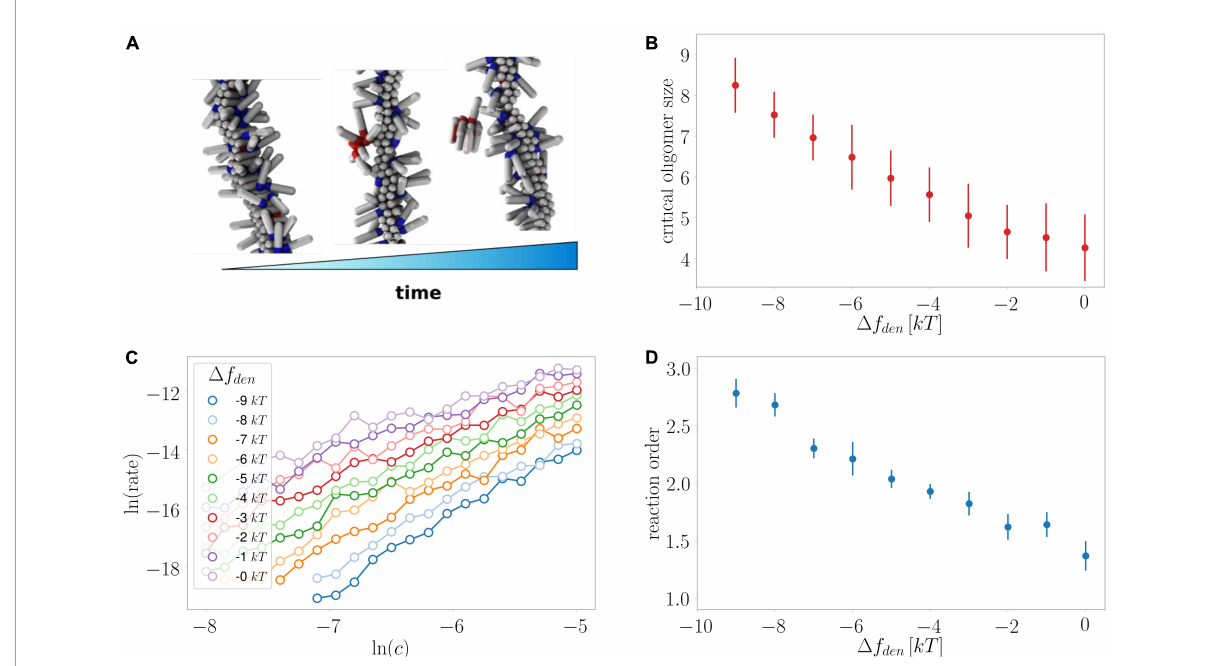
FIGURE10 Monte Carlo simulations of secondary nucleation. (A) Depiction of the formation and detachment of a secondary nucleus of critical size as simulated in the current study. (B) Average critical nucleus size versus the effect of denaturant on the free energy of the protein in the unfolded monomeric state. (C) The rate of secondary nucleation versus monomer concentration for a number of effects on the free energy of the monomeric protein. (D) The reaction order determined from the data in panel (C) versus the effect of denaturant on the free energy of the protein in the unfolded monomeric state. Oligomer size as well as reaction order are larger when the stabilising effect of denaturant on the unfolded state is